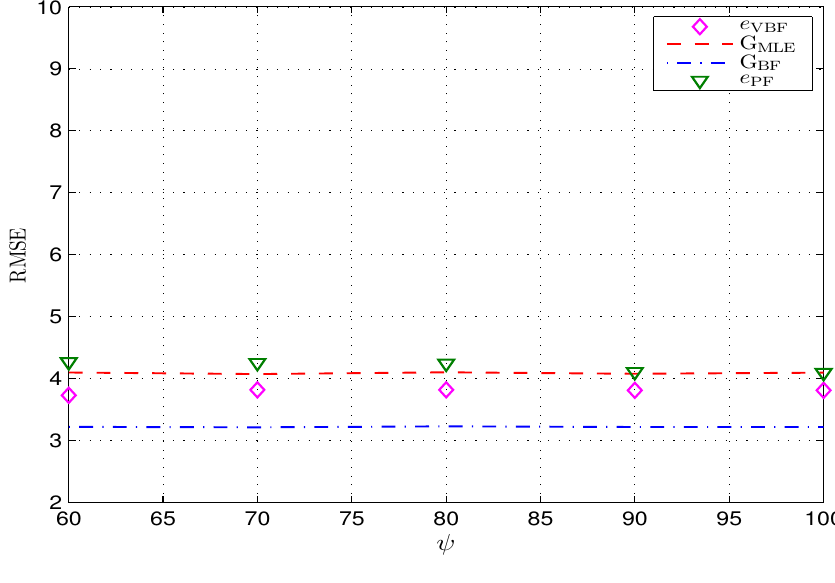
Figure 7. Achieved RMSEs over different deep shadow fading environments with the same expectation of w . The y -axis is in t